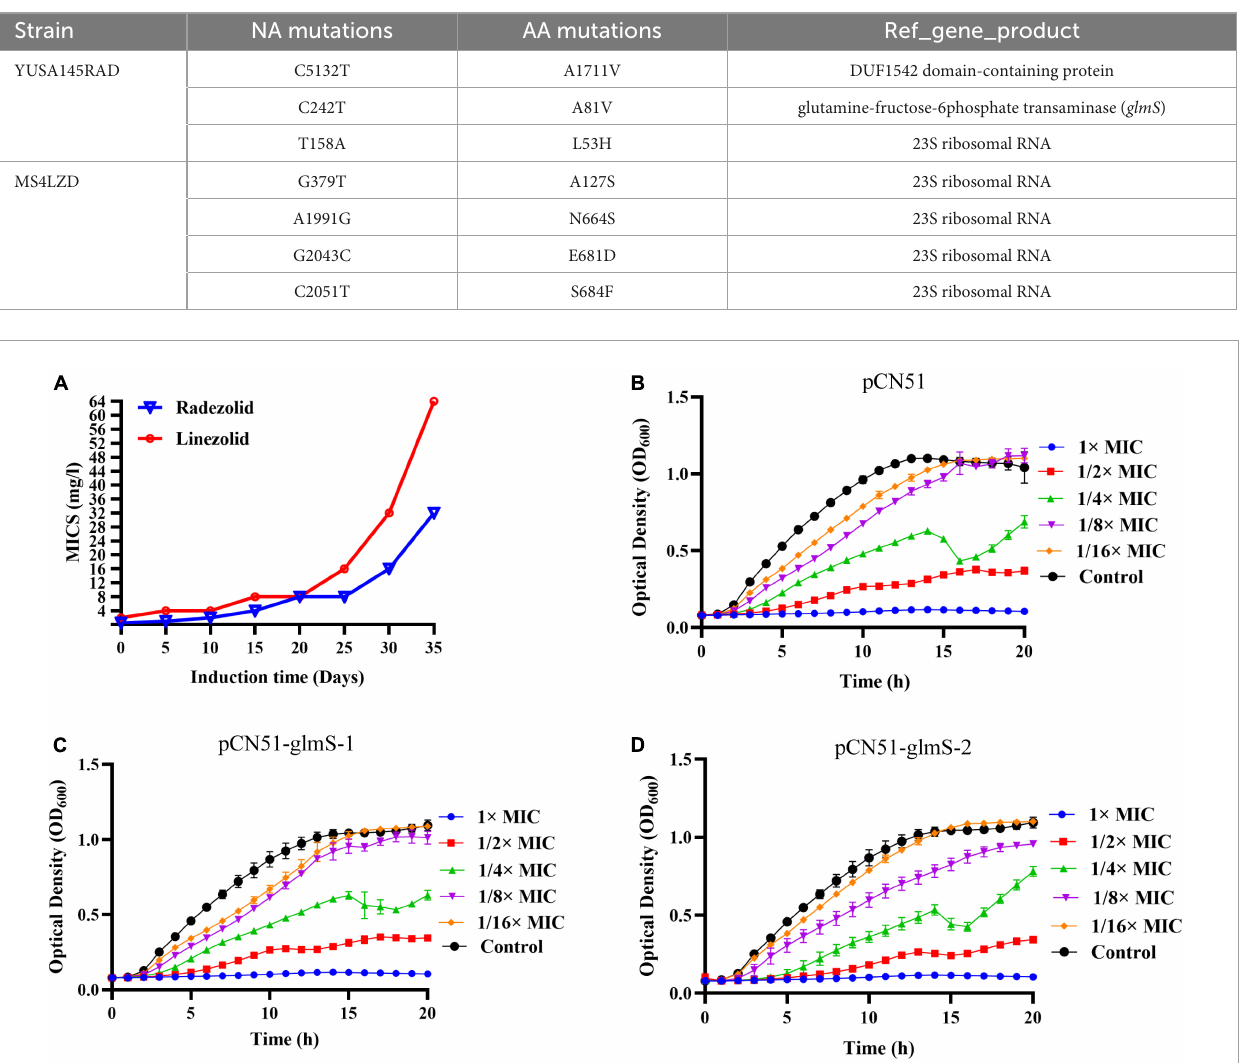
FIGURE1 (A) Staphylococcus aureus YUSA145 resistance to radezolid in vitro induction. (B–D) The planktonic growth curve of S. aureus SA113 with glmS overexpression and the control transfected with a pCN51 empty vector. The presented data were the average of three independent experiments (mean ±